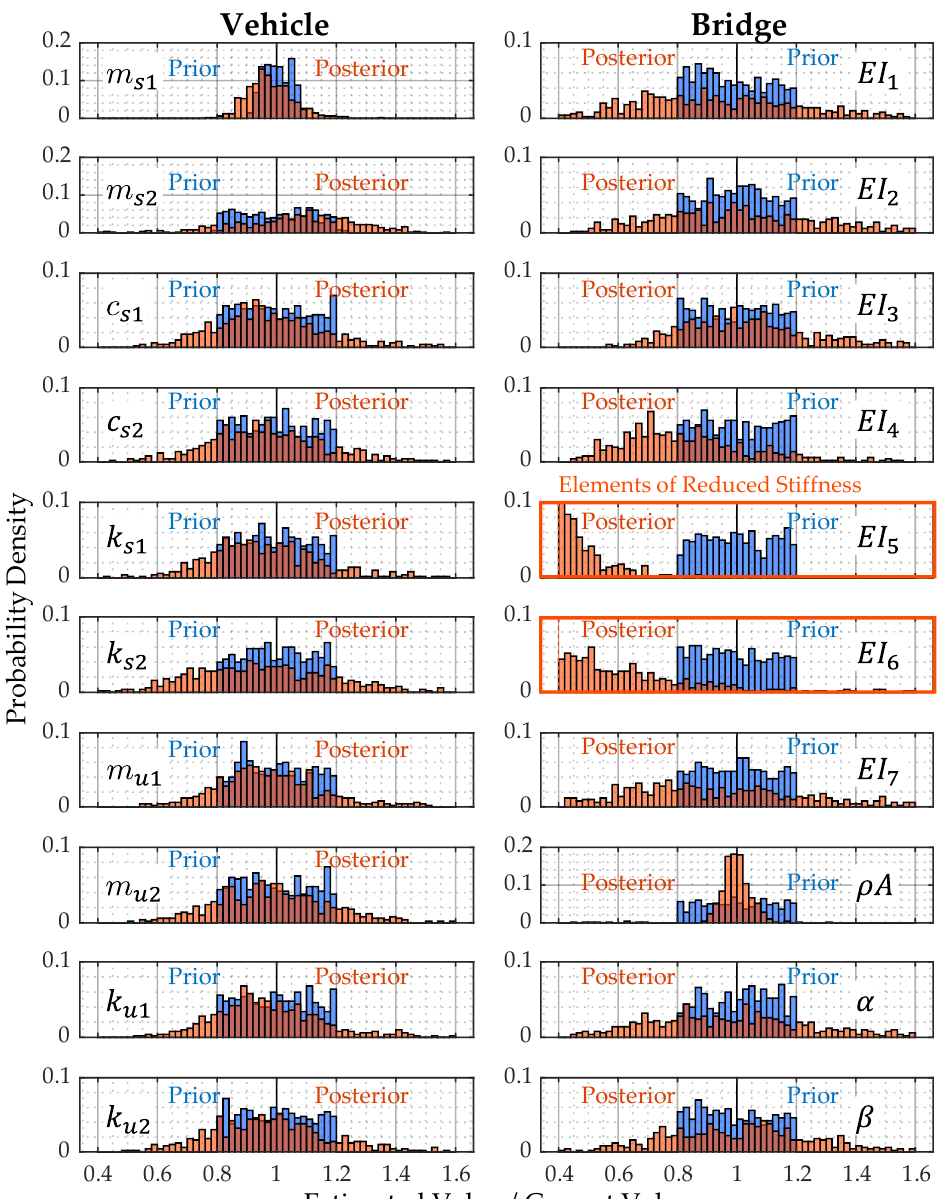
Figure A11. The application results of the PRE method in the case of Scenario 9 (stiffness decrease section: 4𝐿/7 ~ 6𝐿/7 , decrease rate: 60%).